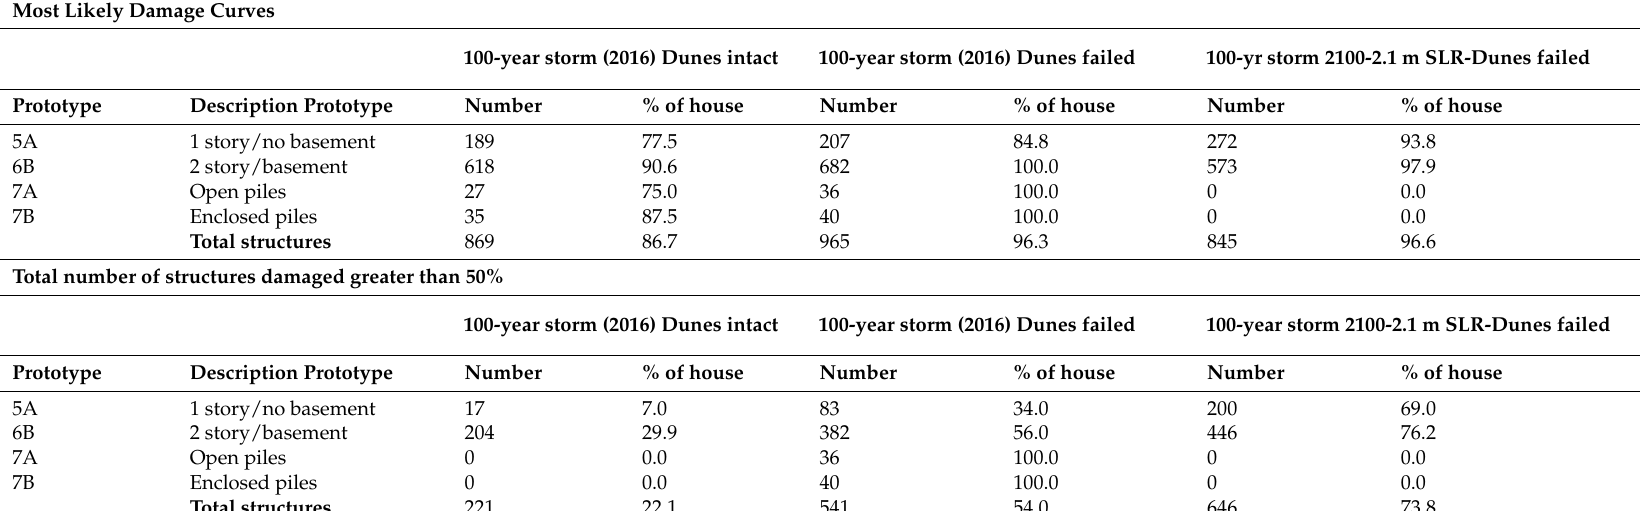
Table 3. Number of structures damaged for the Charlestown, RI study area for various scenarios. Damages are based on the most likely curve. Upper panel shows all structures damaged while lower panel shows structures that are more than 50%